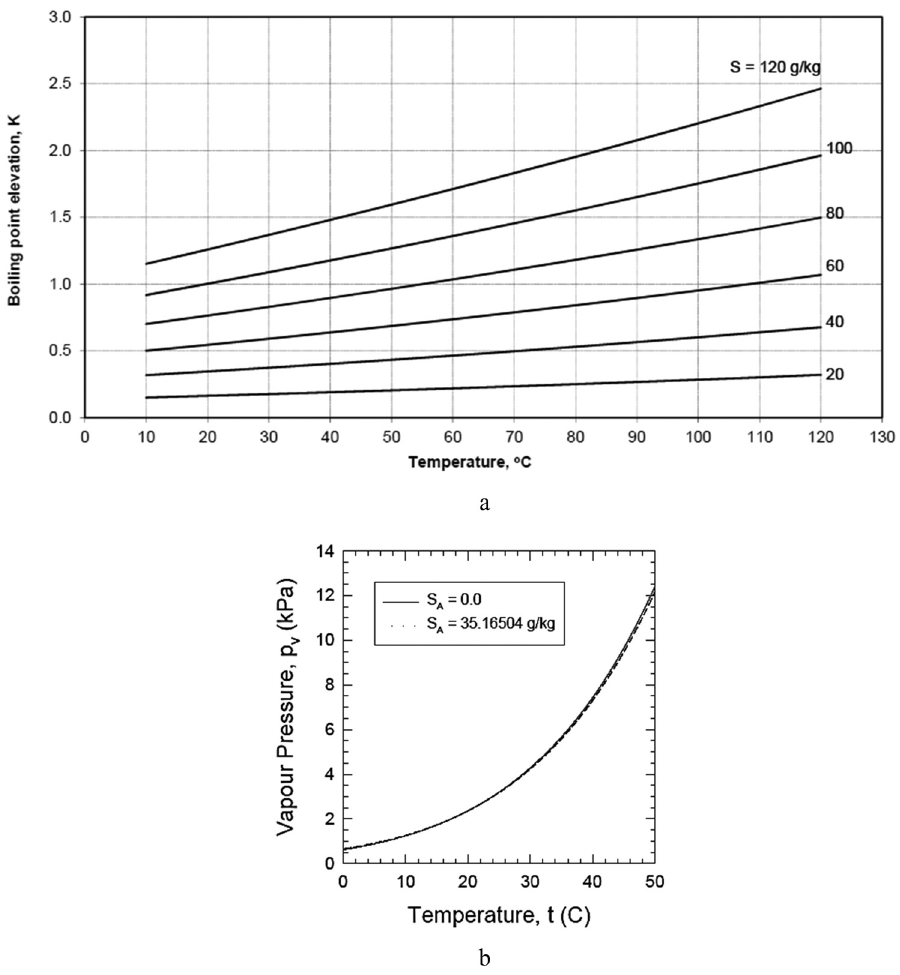
Figure 5: ( a ) Boiling point elevation of seawater based on salinity variation and ( b ) vapor pressure to temperature comparison relates to the salinity [ 34 ]